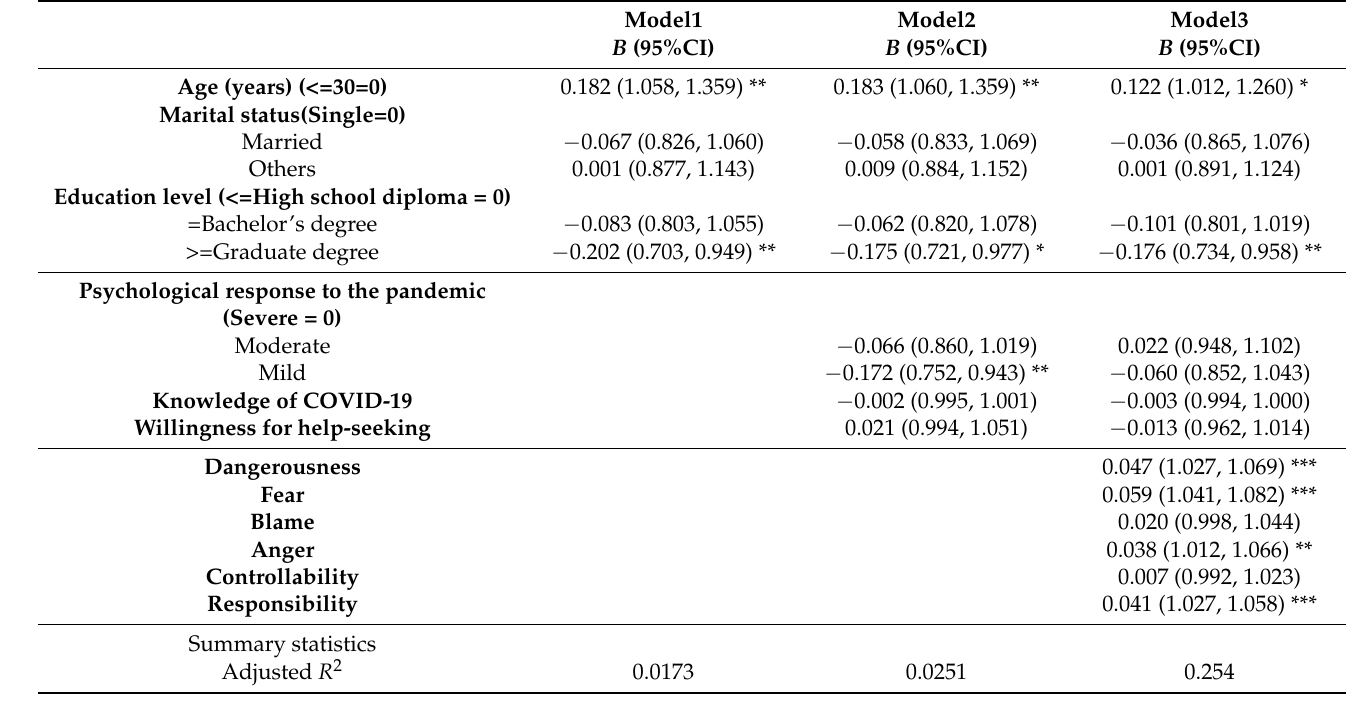
Table 4. Linear regression models of public stigma of